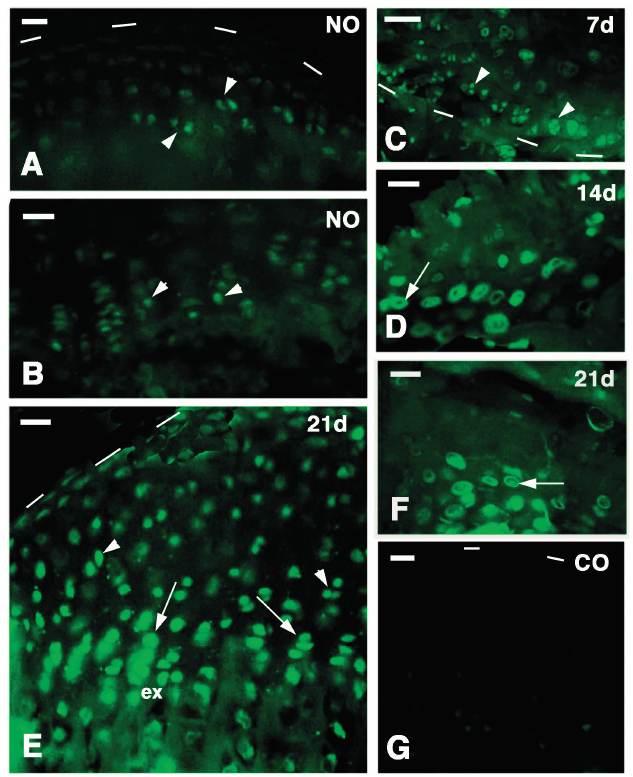
Figure 3. Chondroitin Sulfate Proteoglycan FITC-immunolabeling. Dashes outline the articular surface. ( A ) Articular cartilage of normal tibia (NO) showing labeling in the isogenous groups (arrowheads) but scarce in the flat chondrocytes of the surface contacting the sinovial cavity (dashes). Bar, 25 µm; ( B ) detail of the labeled cells (arrowheads) within the serial cartilage of a metaphyseal growth plate of a normal tibia (NO). Bar, 25 µm; ( C ) labeling in the chondroblasts of the isogenous groups (arrowheads) in a